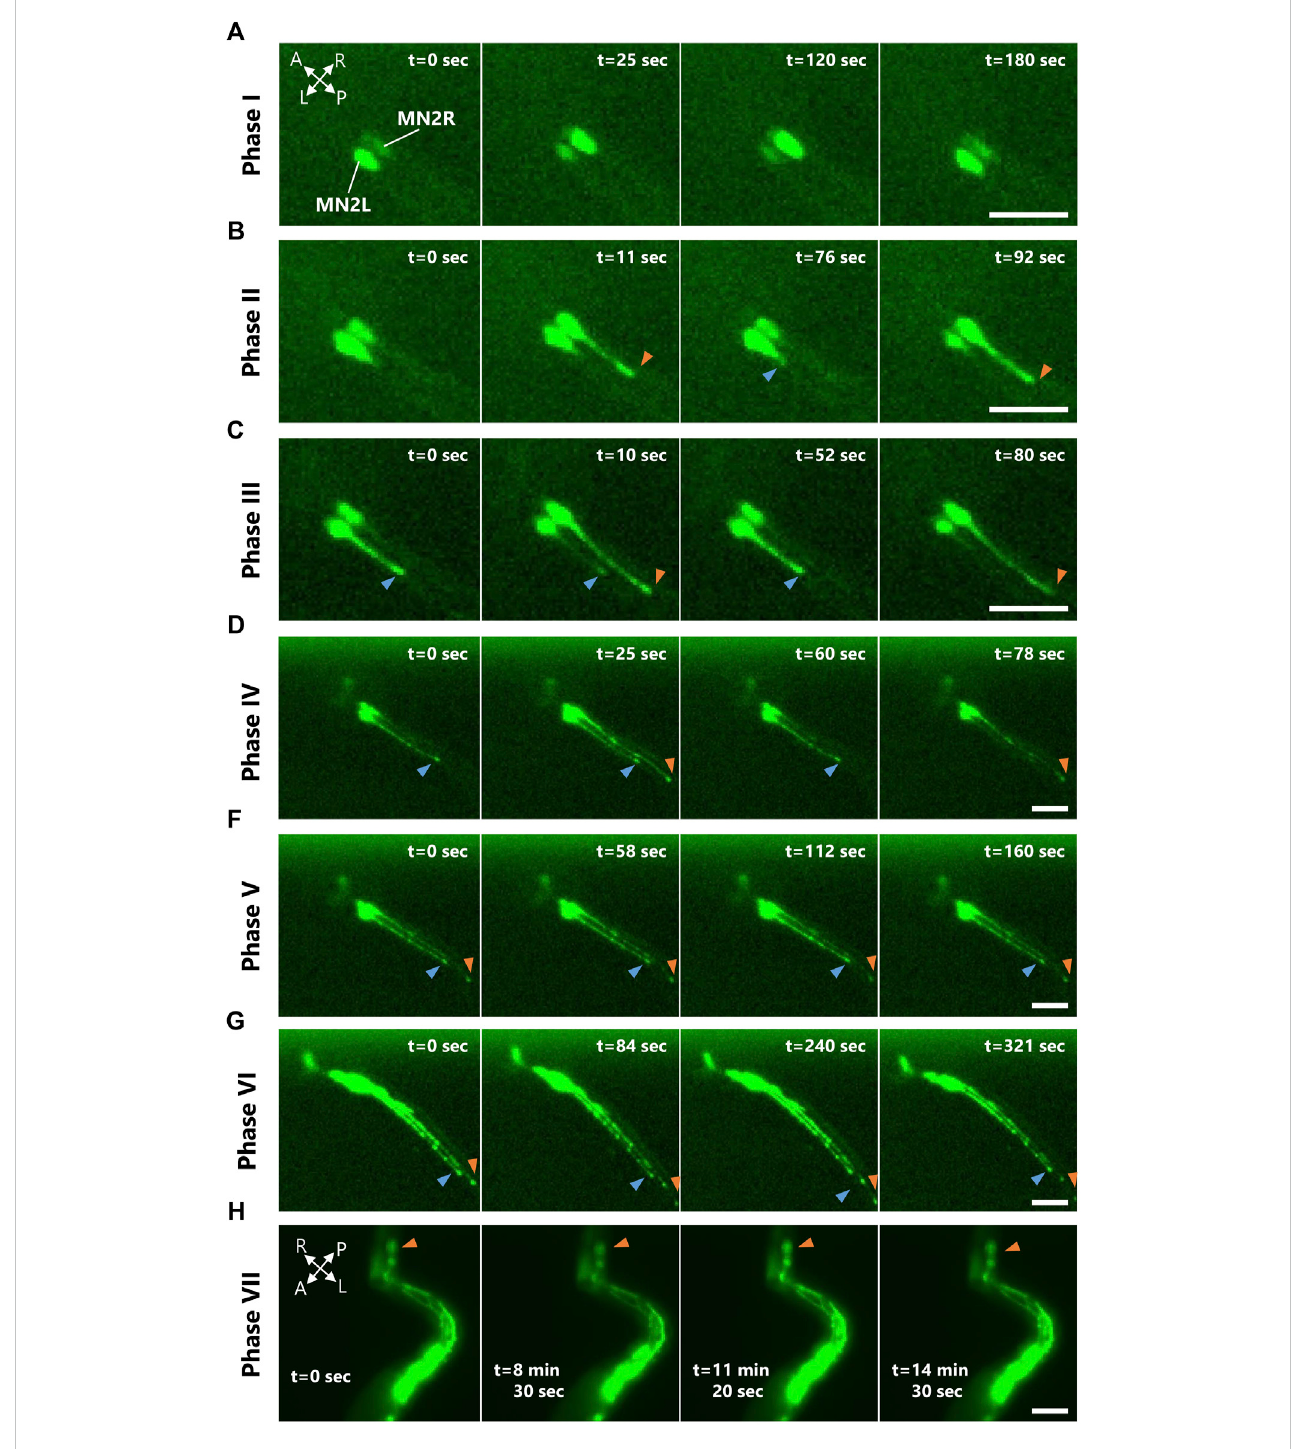
FIGURE 2 MN2L and MN2R Ca 2+ transients observed from tailbud stage to tail absorption. Representative images of the four consecutive Ca 2+ bursts occurring in eitherMN2L,MN2R,orbothineachCa 2+ phaseobservedwithpSP-CiVAChT:GCaMP6stransducedlarva.Imagestakenby fl uorescentmicroscopy.A,anterior; P, posterior; R, right; L, left. Blue/orange arrowheads indicate MN2L/MN2Raxon terminals. Scale bar 50 µm. (A) Phase I. (B) Phase Ⅱ . (C) Phase Ⅲ . (D) Phase IV. (E) Phase V. (F) Phase VI. (G) Phase